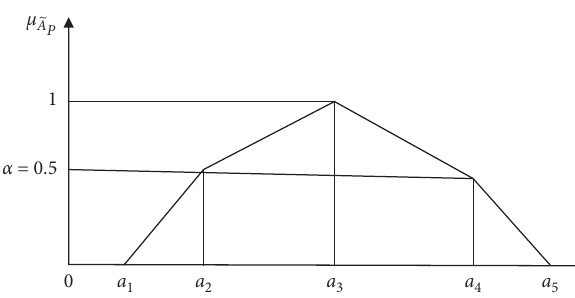
Figure 1: Graphical representation of pentagonal fuzzy number